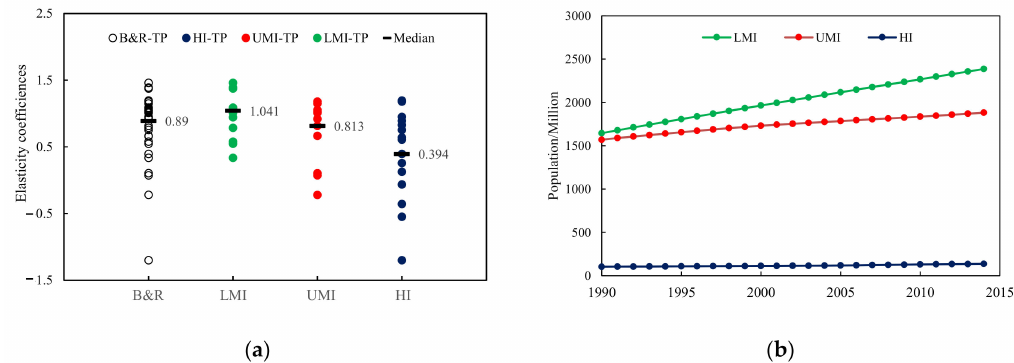
Figure 4. The elasticity coefficiences of population and its changes in different income groups: ( a ) The elasticity coefficiences of the population in B&R countries; ( b ) The changes in the population of three income groups from